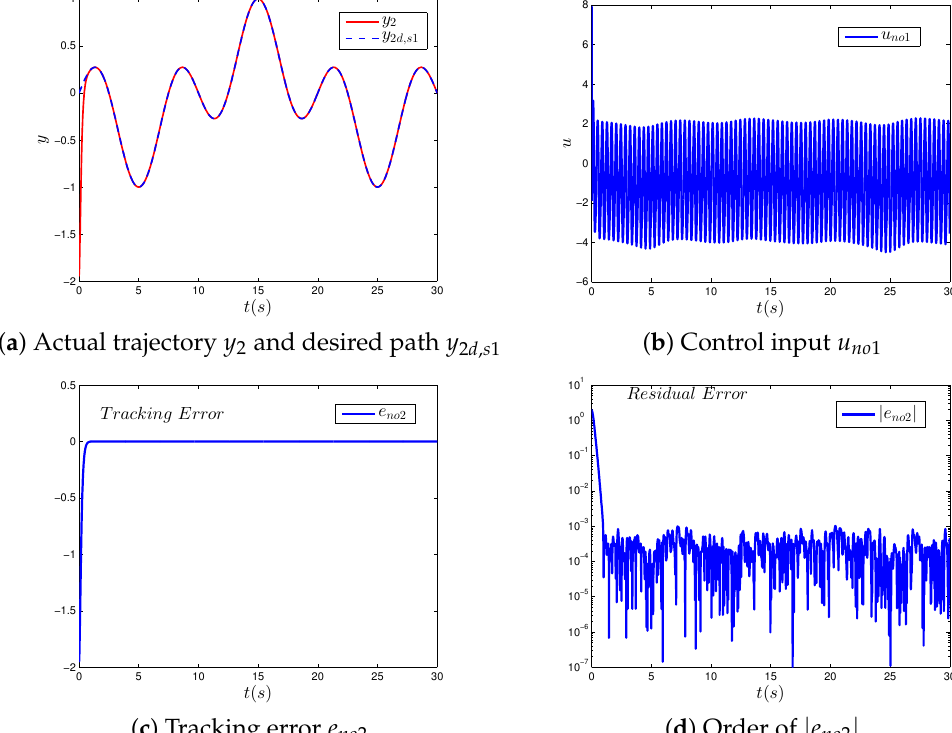
Figure 8. Tracking performance of ZGD controller (26) to solve the tracking control problem with single nonlinear output of the single-link manipulator with flexible joints for the desired path y 2 d , s 1 = sin ( 0.1 π t ) cos ( 0.2 π t )